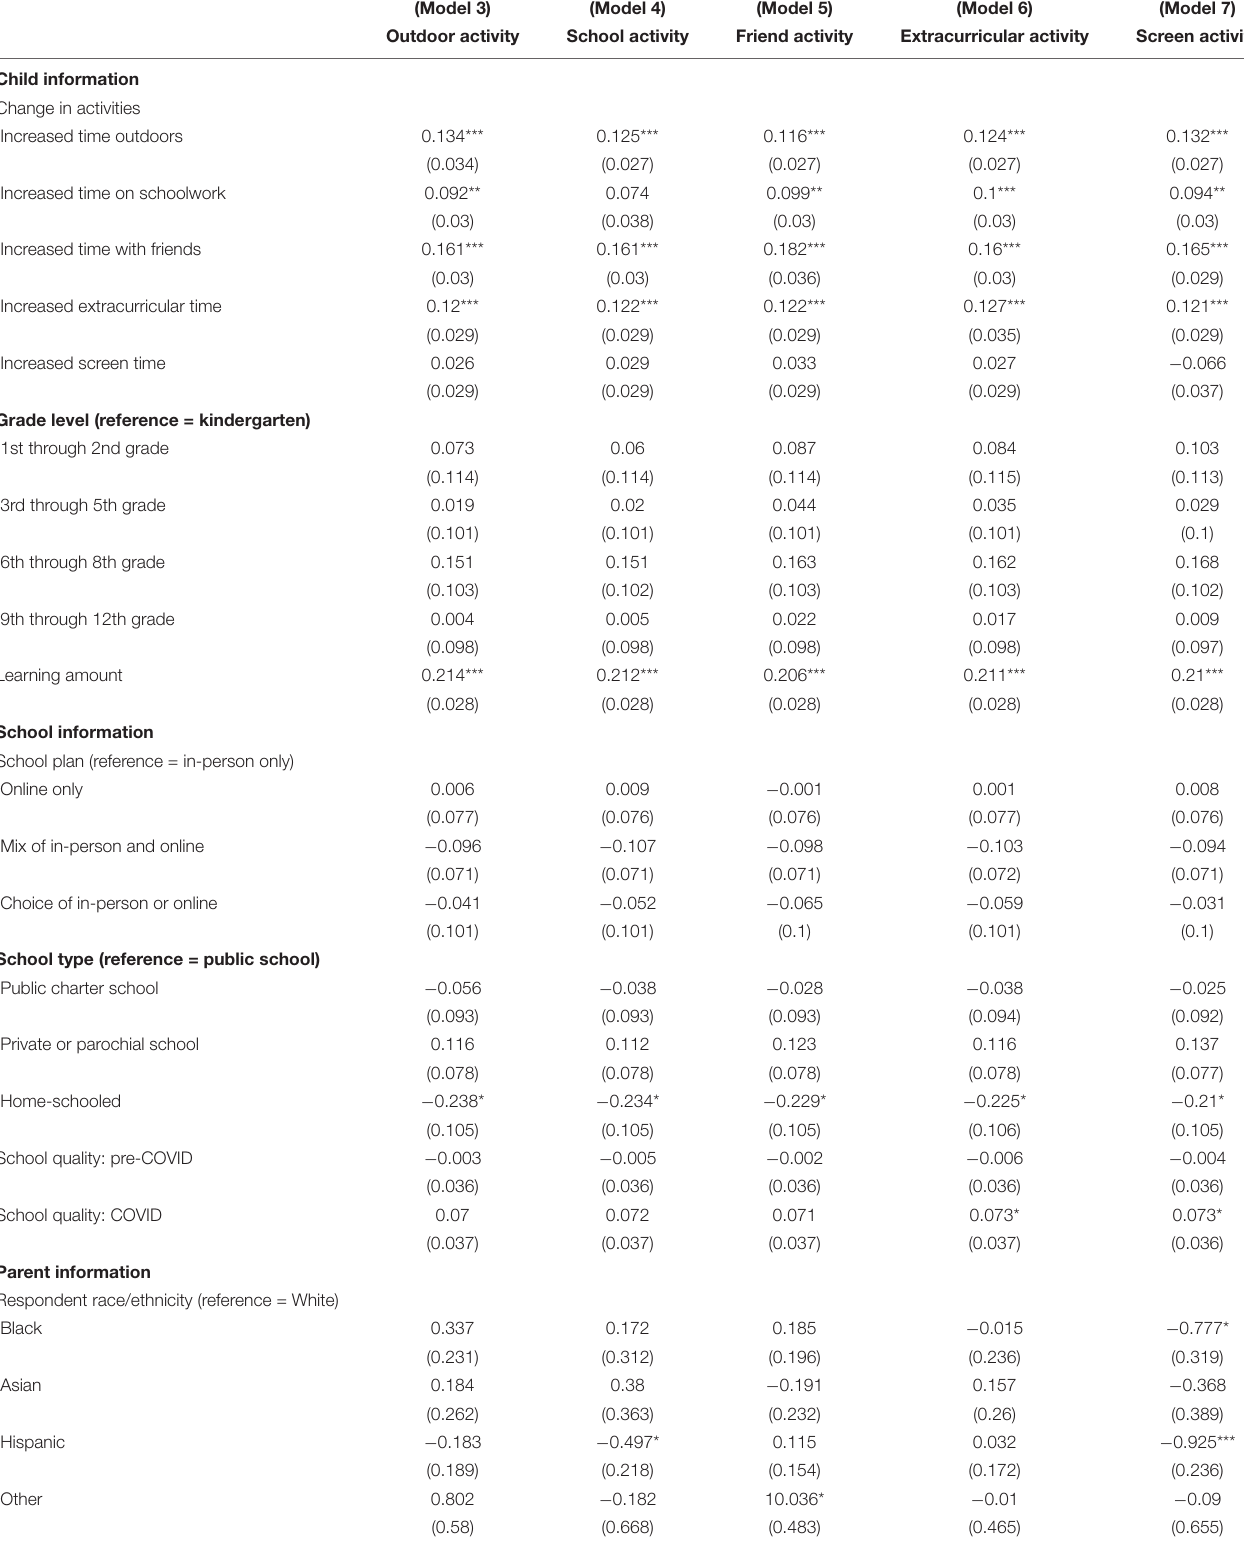
TABLE 3 | Child activities and social skills with race interactions skills (outcome: increase in social